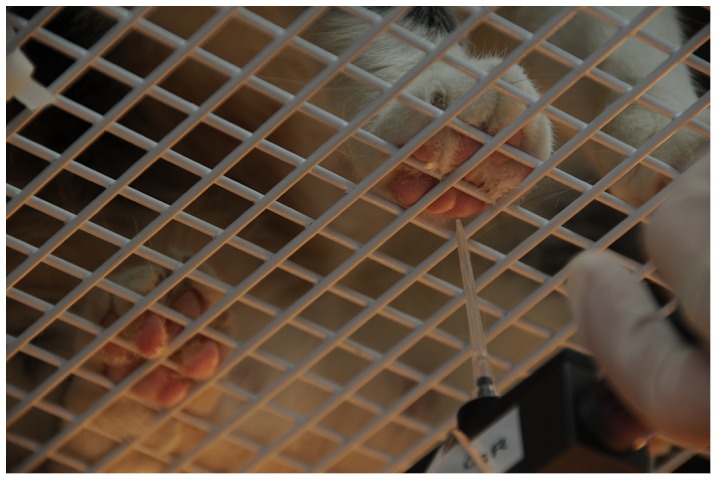
Photograph of the placement of the von Frey probe.During evaluation, the cats stood in a meshed cage, the probe tip was placed perpendicular to the plantar surface of the foot, and an increasing force was applied without manipulating the limb.